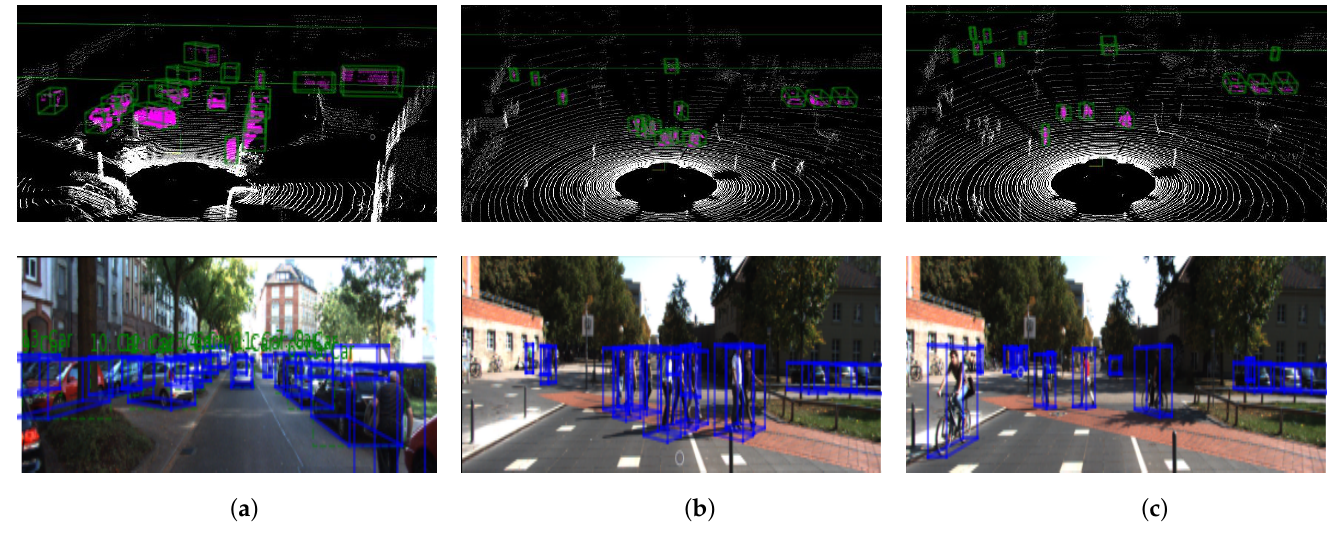
Figure 3. ( a ) Cars, ( b ) pedestrians, ( c ) cyclists. Qualitative analysis of our LiDAR-based 3D object detection model on the KITTI dataset (zoomed view). For better visualization, we used the bird’s eye view (top) and image perspective (bottom). The ground truth boxes are shown in blue, whereas the predicted boxes are in green. Even though the cars ( a ) are overlapped, and some are occluded, the network can detect